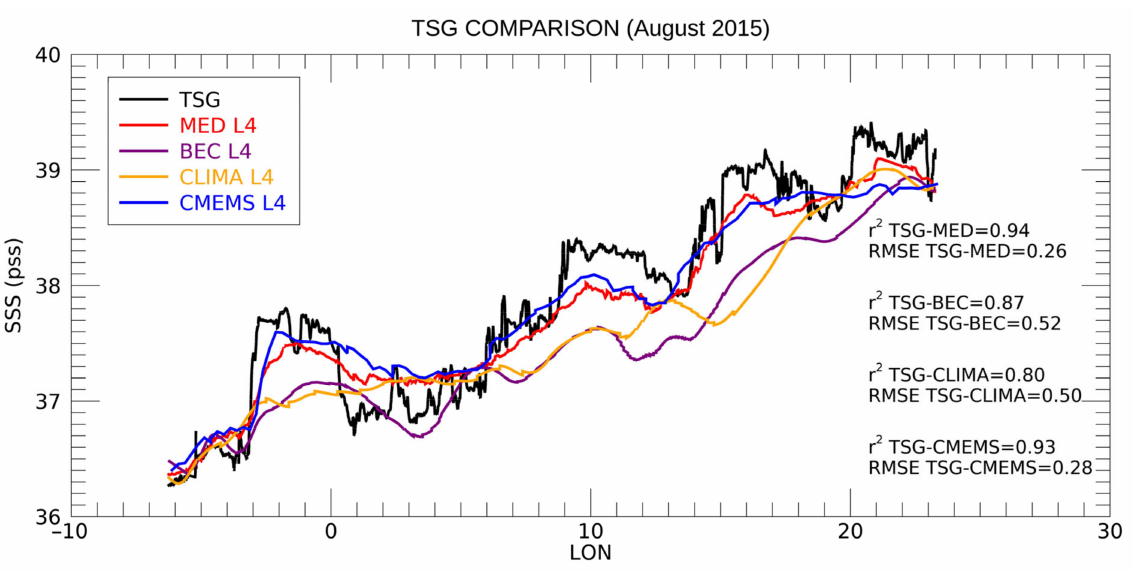
Figure 9. Comparison between TSG observations (black line), Med L4 SSS (in red), BEC L4 SSS (in purple), in situ monthly climatology L4 SSS (in yellow), and CMEMS L4 SSS (in blue). The TSG trajectory refers to trans-Mediterranean track samples, between 20–25 August